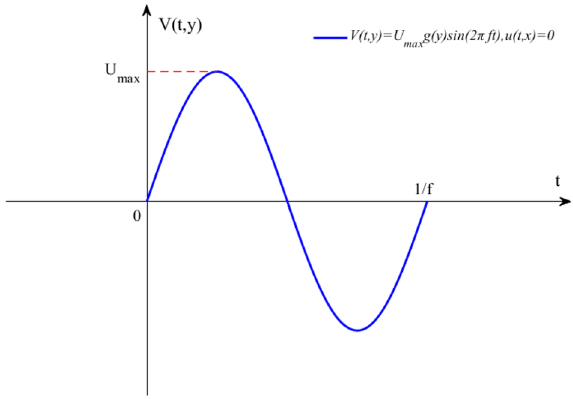
Figure 1. Velocity profile for Eq.